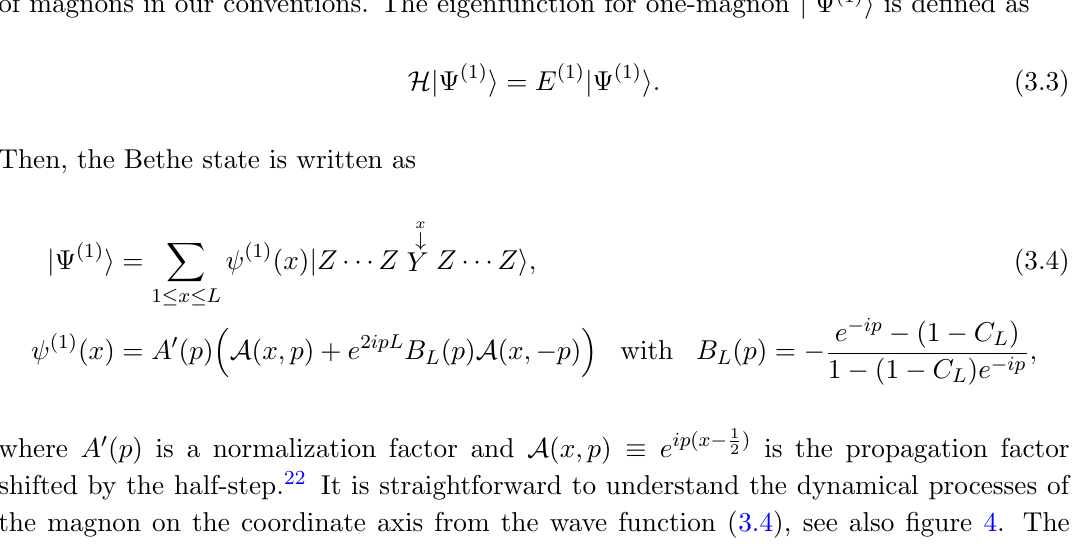
( x; p ). On A p . Finally, ! (cid:0) ( x; p ) = e ip ( L (cid:0) ( x (cid:0) 1 2 )) A (cid:0)